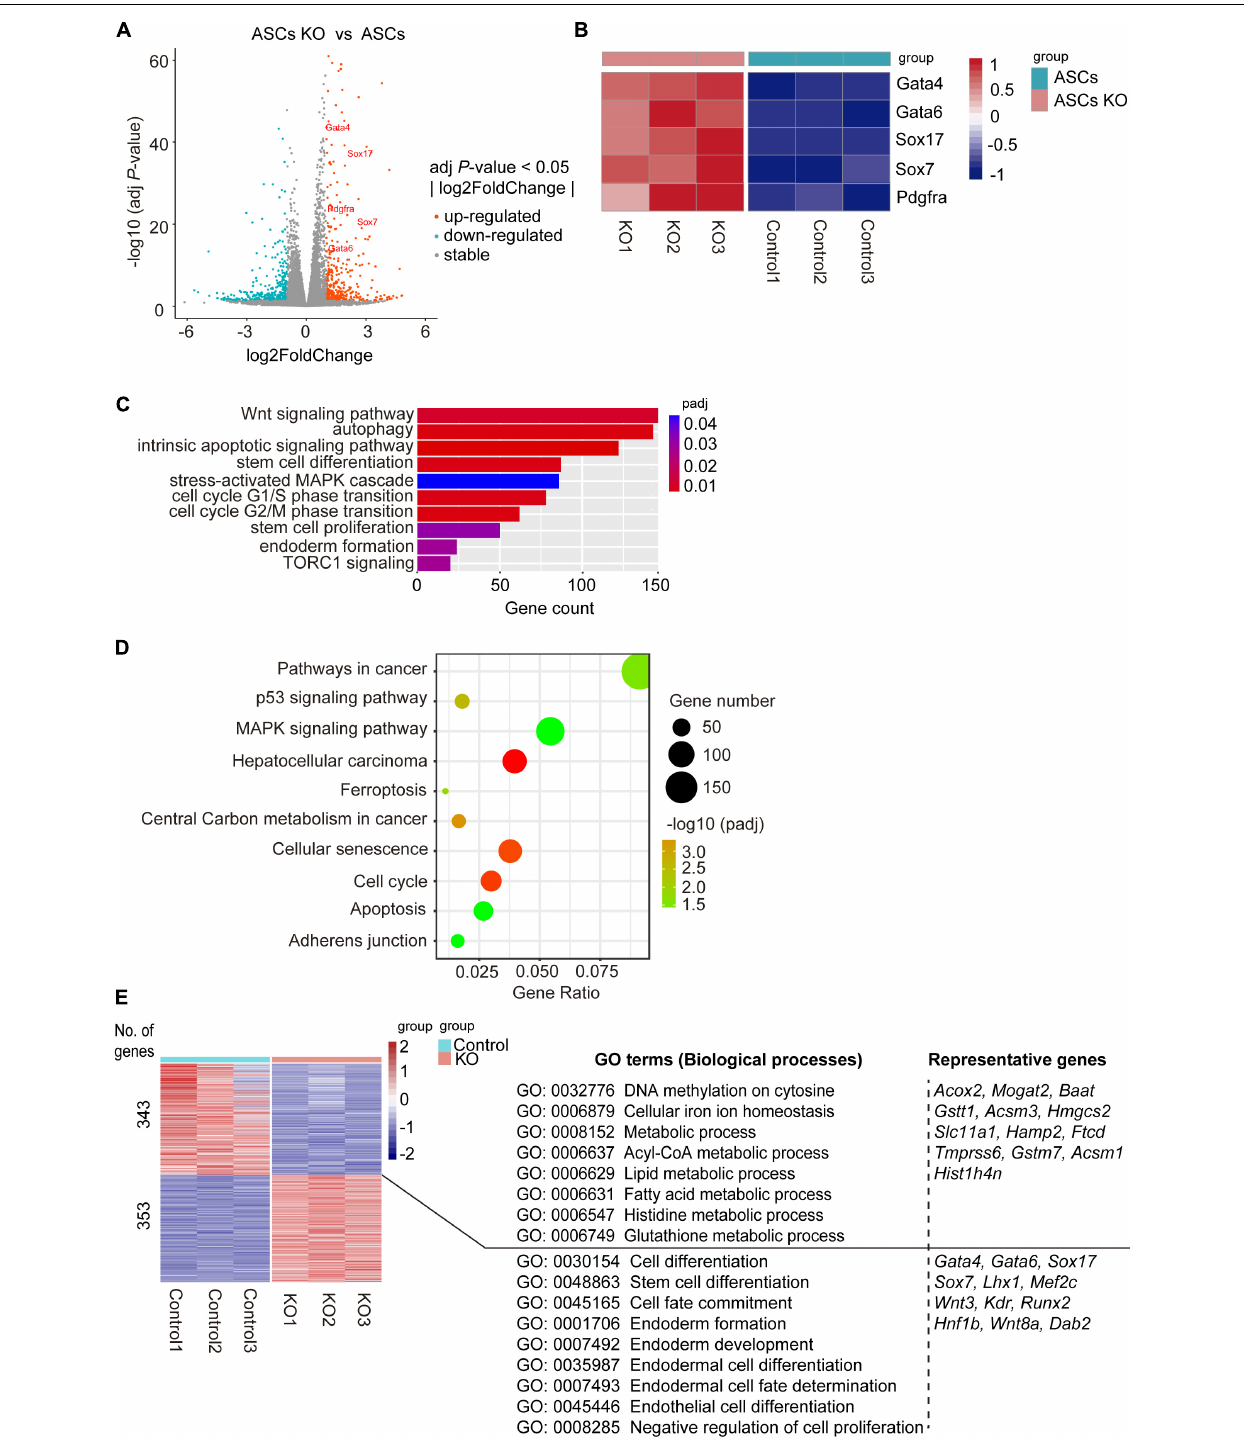
Frontiers in Cell and Developmental Biology |